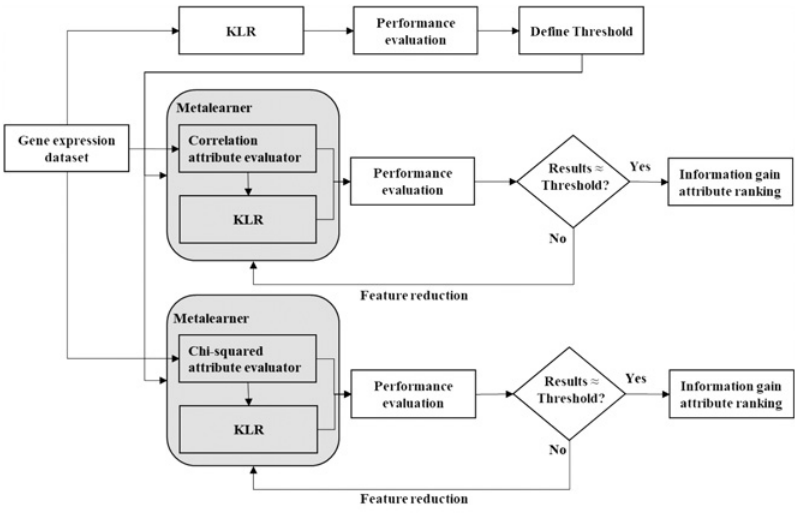
Figure 1: Procedures